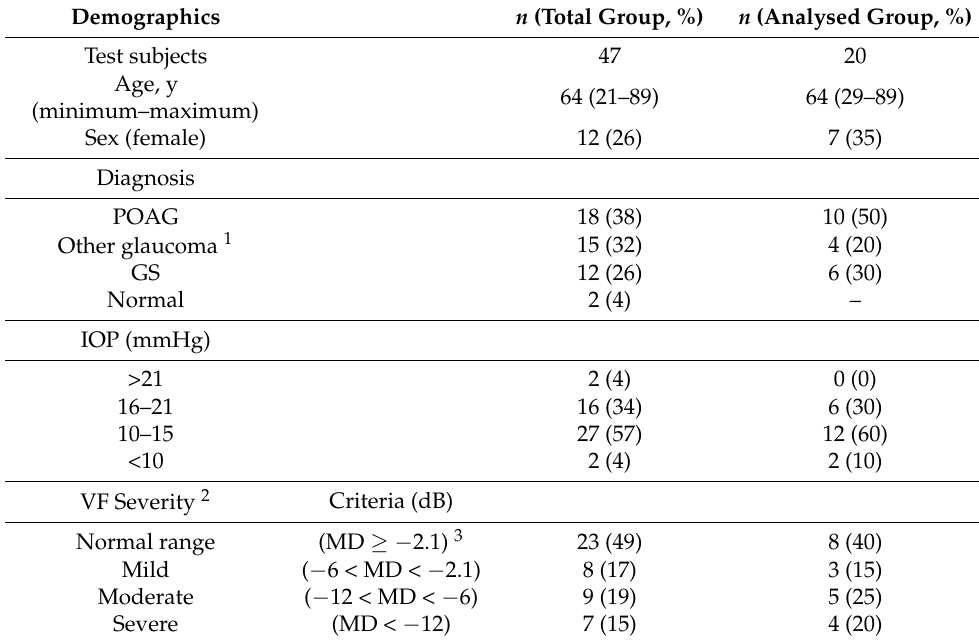
Table 1. Patient demographics for compliance